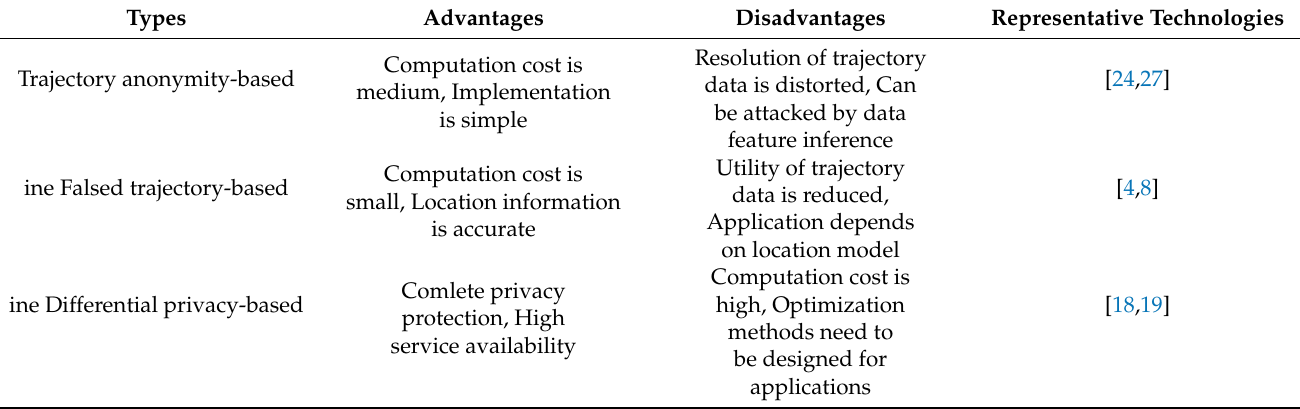
Table 1. Three kinds of trajectory privacy-preserving